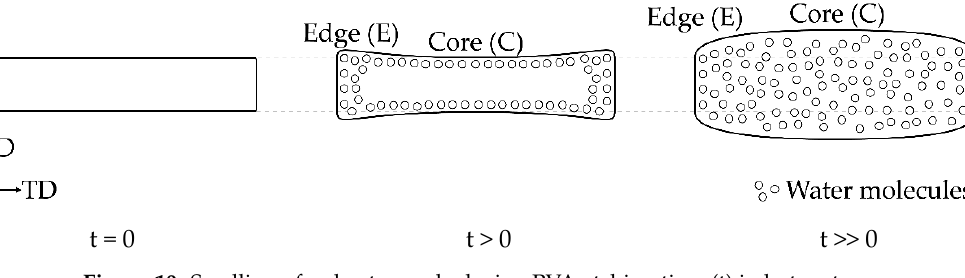
Figure 10. Swelling of a sheet sample during PVA etching time (t) in hot water.